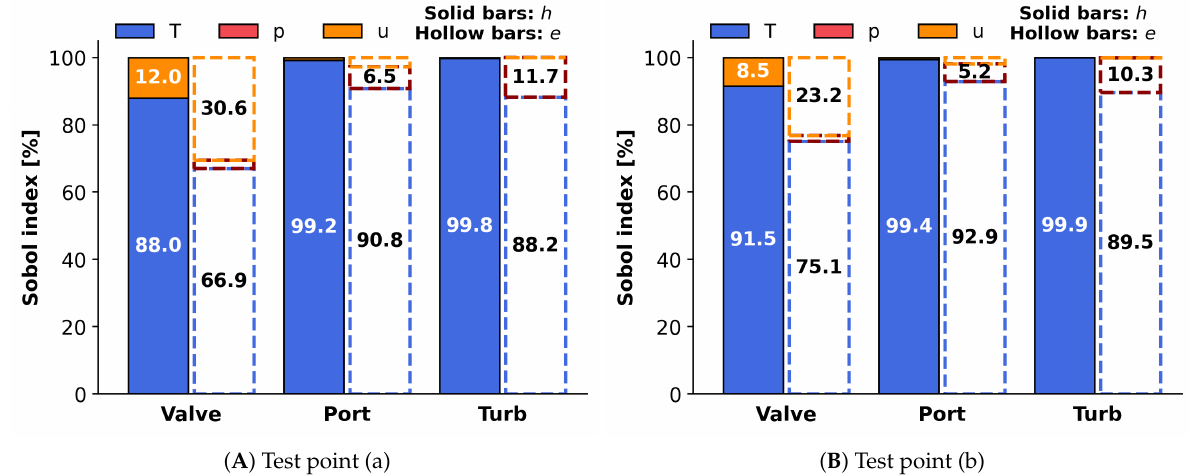
Figure 14. The significance of flow parameters for specific enthalpy and exergy at the tested operating points. The solid bars represent enthalpy, and the hollow bars are for